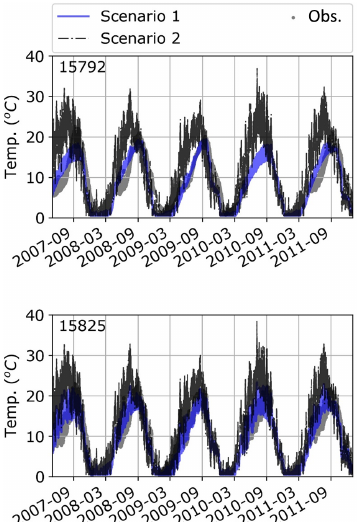
Figure 9. Simulated and observed water temperatures in the Farm- ington River downstream from West Branch reservoir (CTDEEP- 15792 and CTDEEP